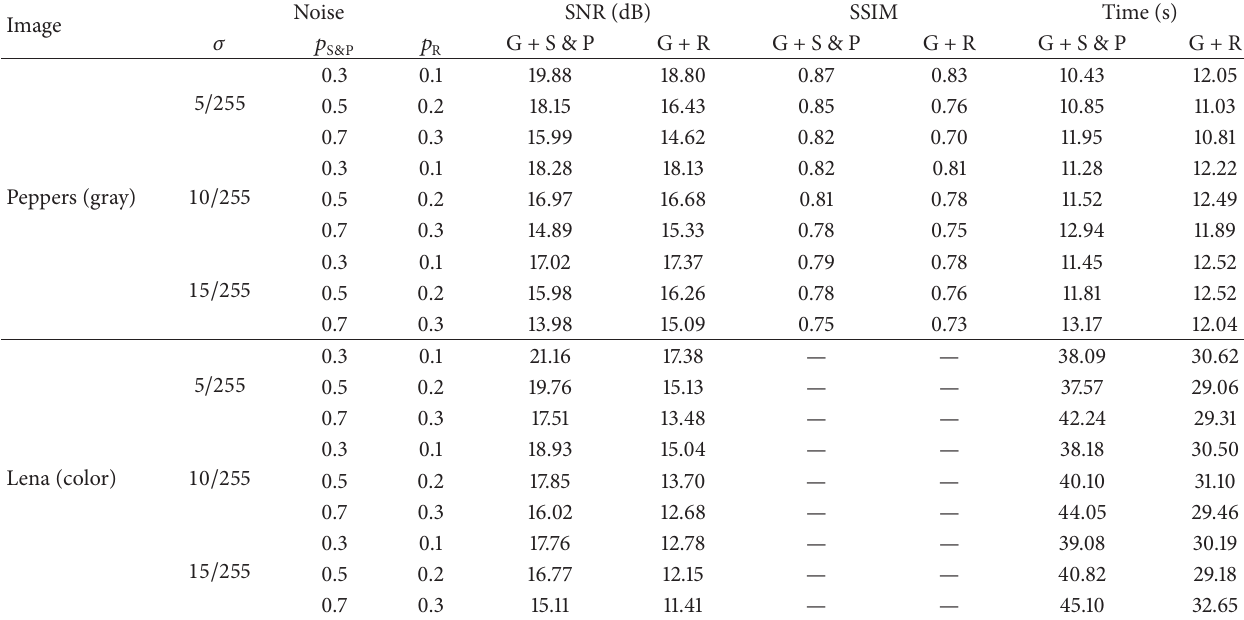
Figure 5: TV denoising for the mixed Gaussian-Impulse noise model via [118] (a spatially adaptive algorithm). Table 5: Denoising performance results for the mixed Gaussian Impulse TV method for the grayscale “Peppers” and the color “Lena” images (both 512 × 512 ). The Gaussian plus Salt & Pepper noise case is marked as “G + S & P”, whereas the Gaussian plus random-valued impulse noise case is marked as “G +